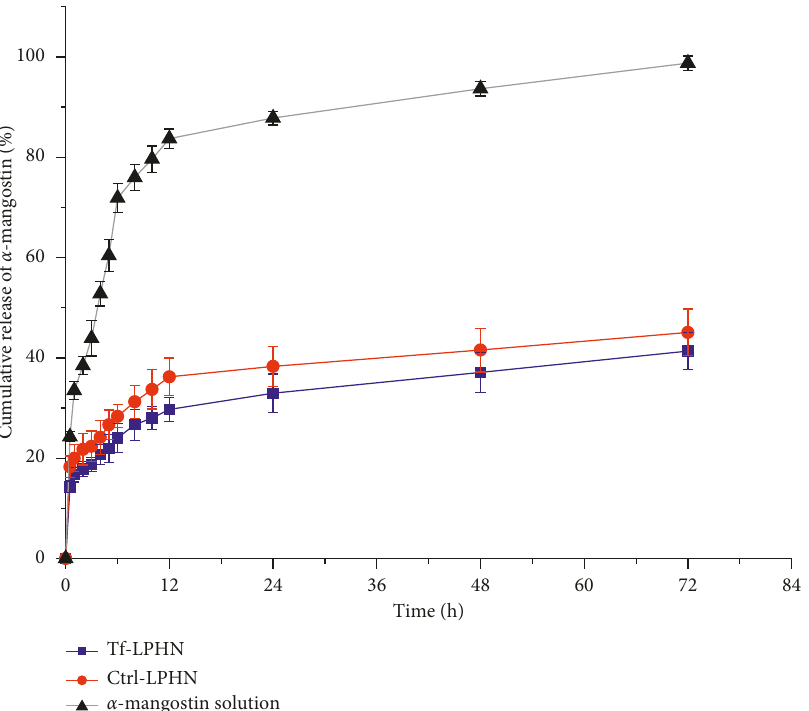
Figure 3: Drug release profile of α -mangostin formulated as Tf-LPHN and Ctrl-LPHN or as a free drug in phosphate buffer saline containing 0.5% Tween 20 at pH 7.4 over 72 hours ( n � 3).